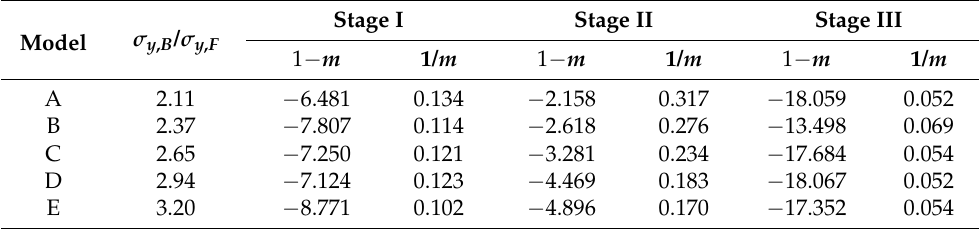
Table 2. Strain hardening capability of models.